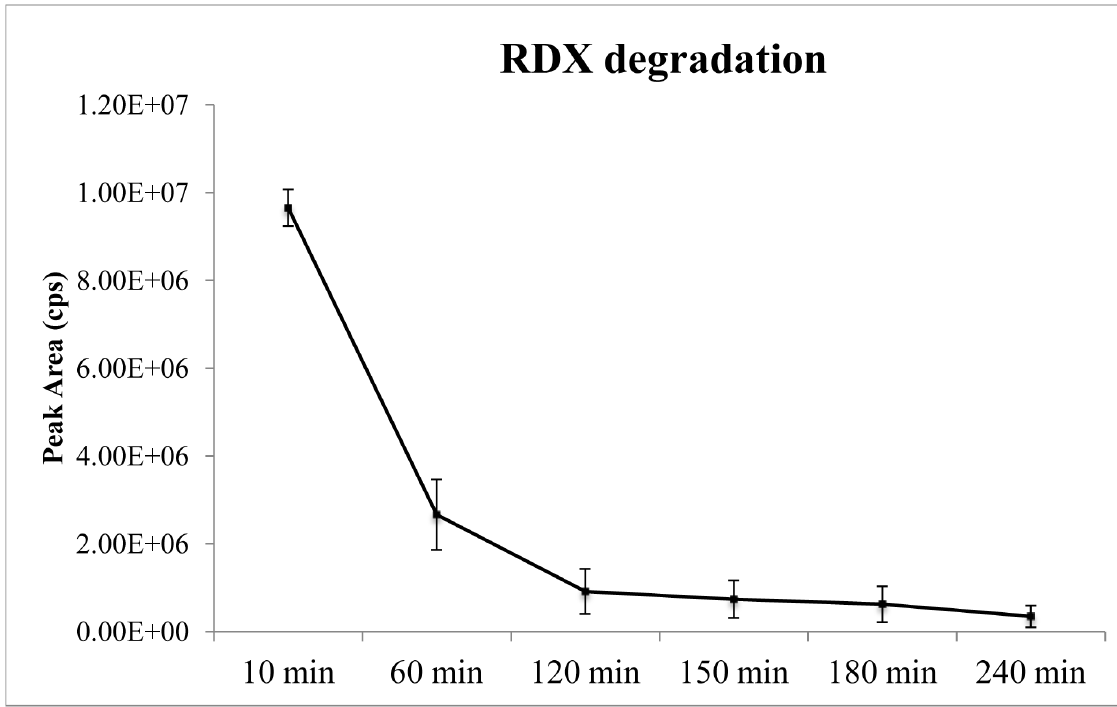
Table 1. The relative abundance of genes involved in RDX degradation in the ovine rumen.